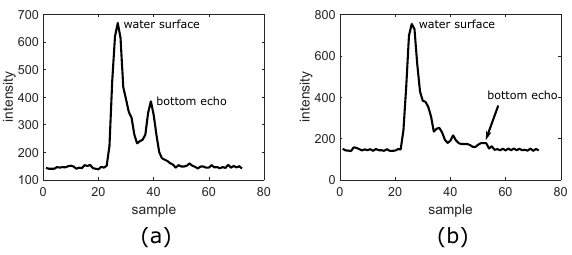
Figure 2. Full-waveforms with (a) two clearly visible signals for the water surface echo and the bottom echo as well as (b) water surface echo and bottom echo with less intensity.